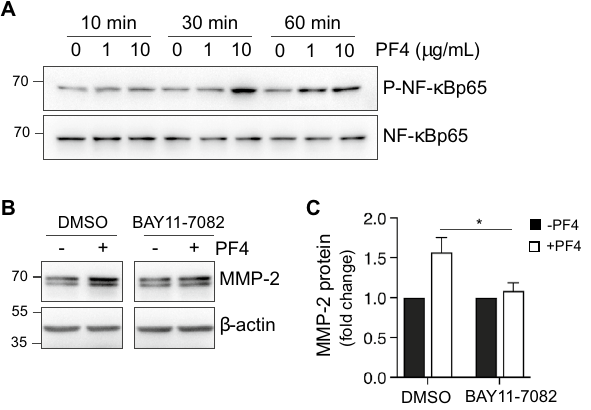
Figure 3. PF4 activates NF-κB signaling in hGFs. ( A ) Serum-starved cells were cultured in the absence or presence of recombinant PF4 at the concentrations and for the time periods indicated. Equal amounts of protein from cell lysates were resolved by SDS-PAGE and immunoblotted with antibodies against phospho-NF-kappaB (P-NF-κBp65). Total NF-κB is shown as a loading control. ( B ) Serum-starved cells were pre-treated with either DMSO vehicle or the NF-κB inhibitor BAY 11-7082 (5 µM) for 1 h, prior to treatment with recombinant PF4 (10 µg/mL) for 24 h. Cell lysates were resolved by SDS-PAGE; immunoblots were probed with antibody against MMP-2. β-actin is shown as a loading control. ( C ) Bar graph depicts intracellular MMP-2 in untreated (black bars) and PF4-treated cells (white bars) in the presence of vehicle (DMSO) or the NF-κB inhibitor BAY 11-7082, as represented in ( B ). Data are expressed relative to the untreated control groups (set at 1), and are mean ± SD from three independent experiments. *, p < 0.05, based on